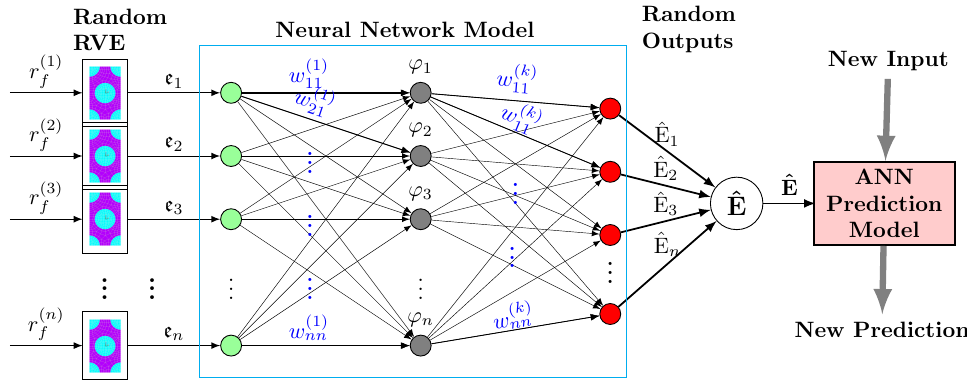
Figure 2. Feedforward ANN for predicting of elastic parameters from microcells with uncertain fiber diameters, d f = 2 r f